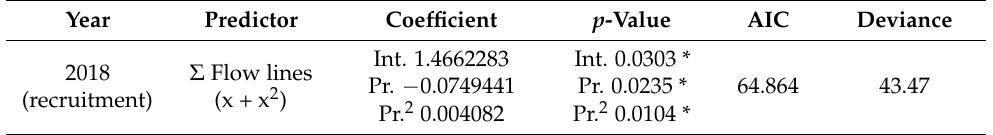
Table 8. Single predictor negative binomial GLM model obtained for early recruitment (2018). Int.: intercept, Pr.: predictor, Pr. 2 : quadratic predictor. Significance codes: * <